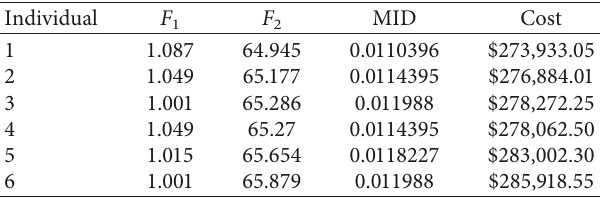
Figure 12: Average interstory drift of individuals per generation. Table 4: Best individuals for model RC-6.